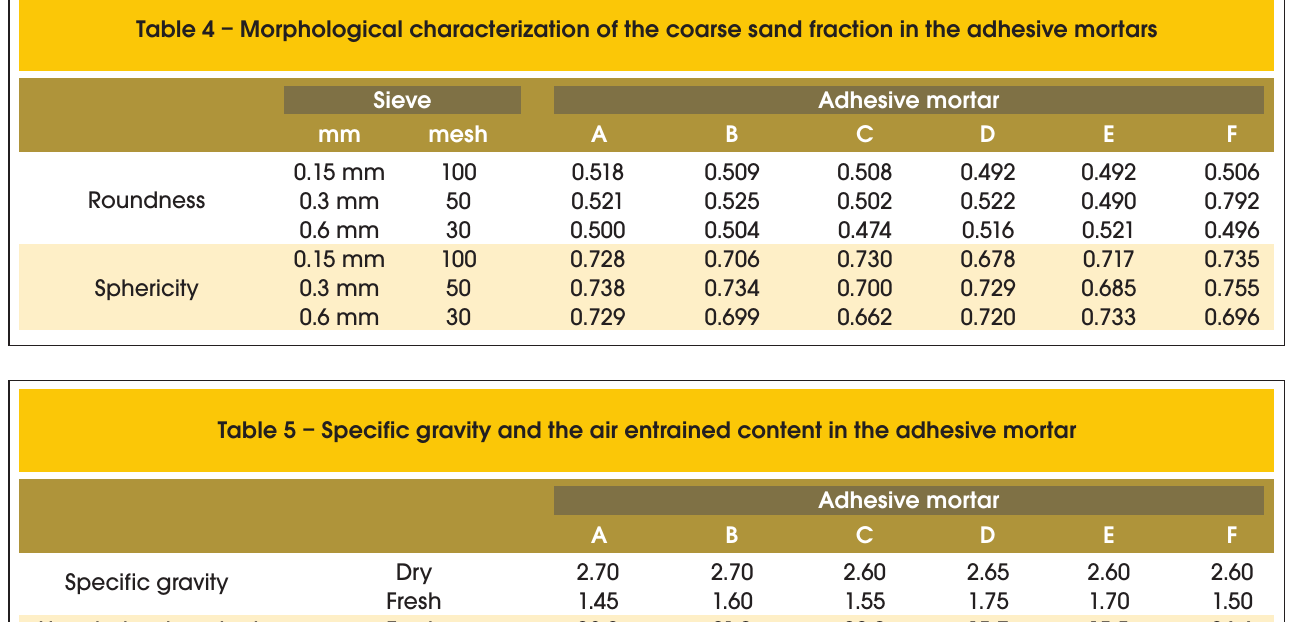
Table 4 – Morphological characterization of the coarse sand fraction in the adhesive mortars